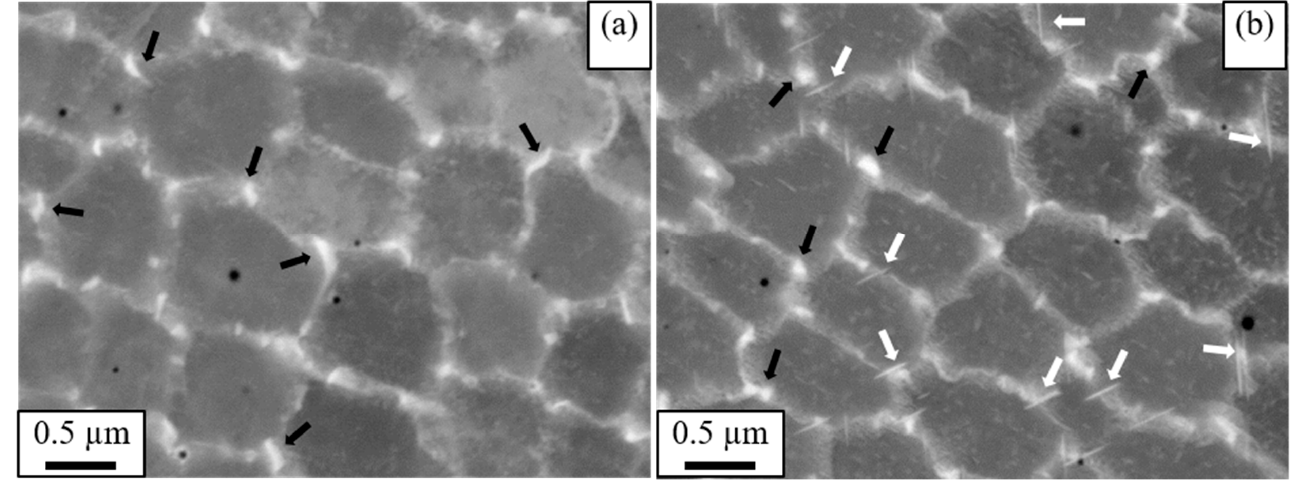
Figure 8. High ‐ magnification image of SEM: ( a ) as ‐ printed and ( b ) direct aged samples. Black arrows indicate Laves phase. Figure 8. High-magnification image of SEM: ( a ) as-printed and ( b ) direct aged samples. Black arrows indicate Laves phase. The white arrows point to the  precipitates. The white arrows point to the δ